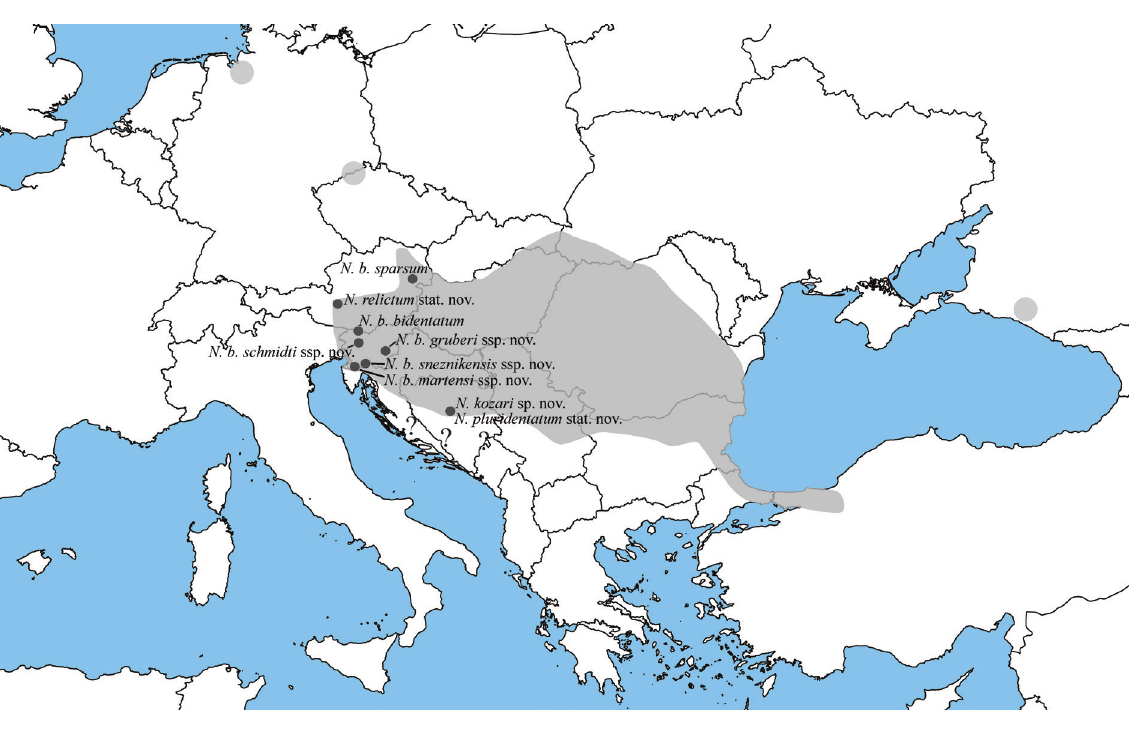
Fig. 2. The complete distributional area of the Nemastoma bidentatum Roewer, 1914 complex, according to Gruber & Martens (1968), Martens (2006), Schönhofer & Holle (2007) and own data, with marked positions of the type localities of the